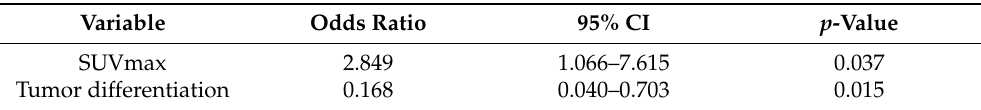
Table 2. Multivariable analysis of the relationship between PD-L1 status and clinicopathologic